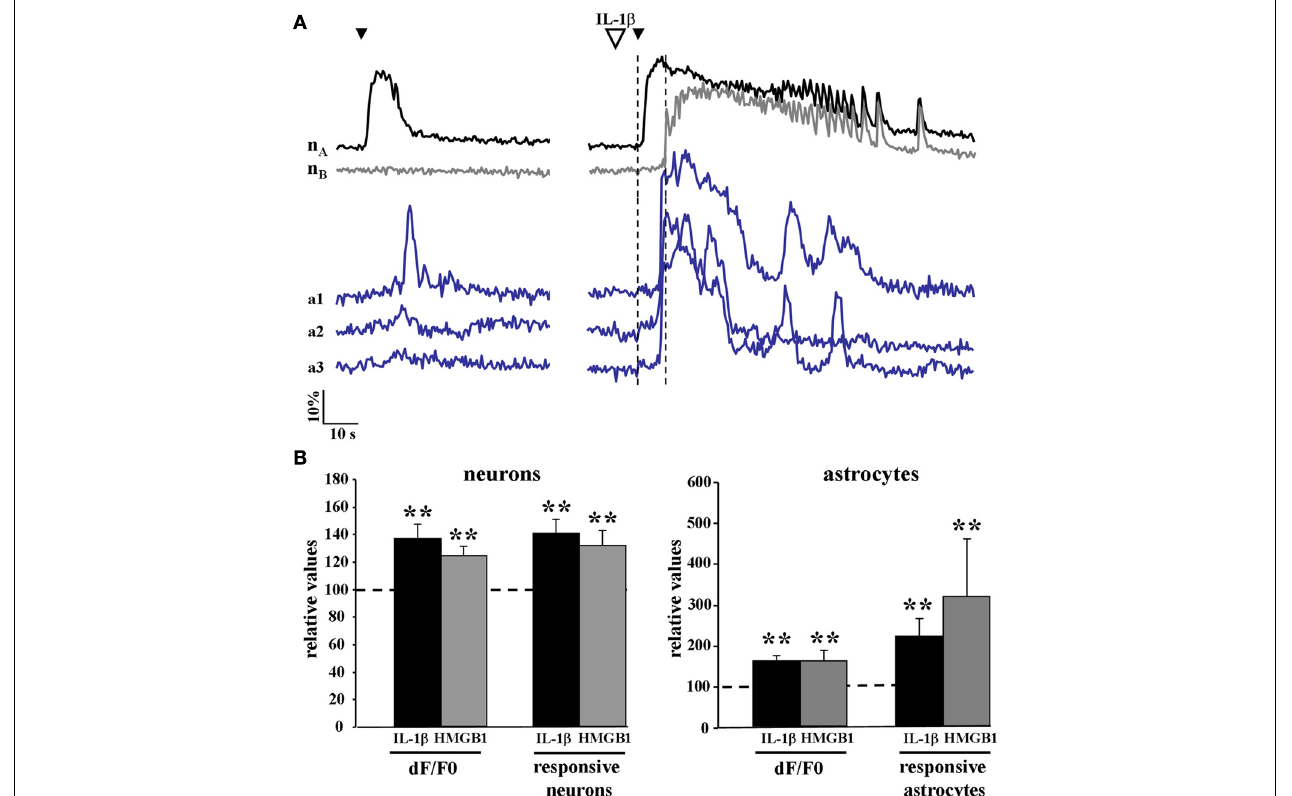
FIGURE 4 | The Ca 2 + responsiveness in neurons and astrocytes to a single NMDA pulse was increased following IL-1 β and HMGB1 applications. (A) representative Ca 2 + changes in neurons and astrocytes evoked by a single NMDA pulse in the absence (left traces) and presence (right traces) of IL1 β . The vertical dashed lines indicate the time interval between the NMDA pulse and the Ca 2 +